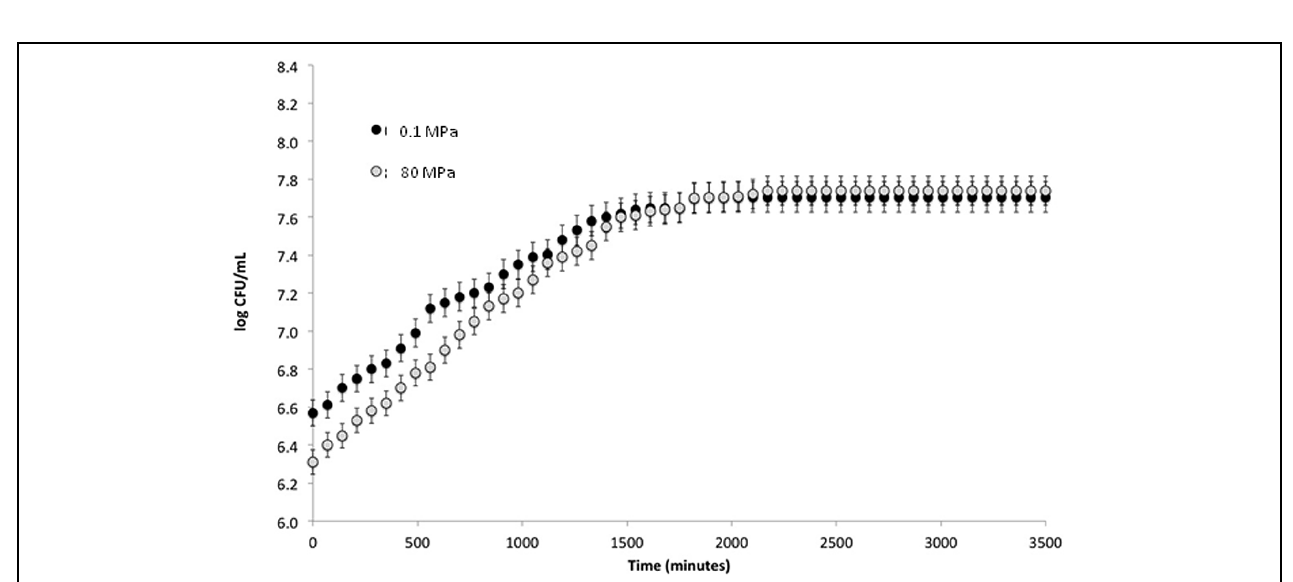
FIGURE 1 | Log CFU ml − 1 plotted against time (min) from